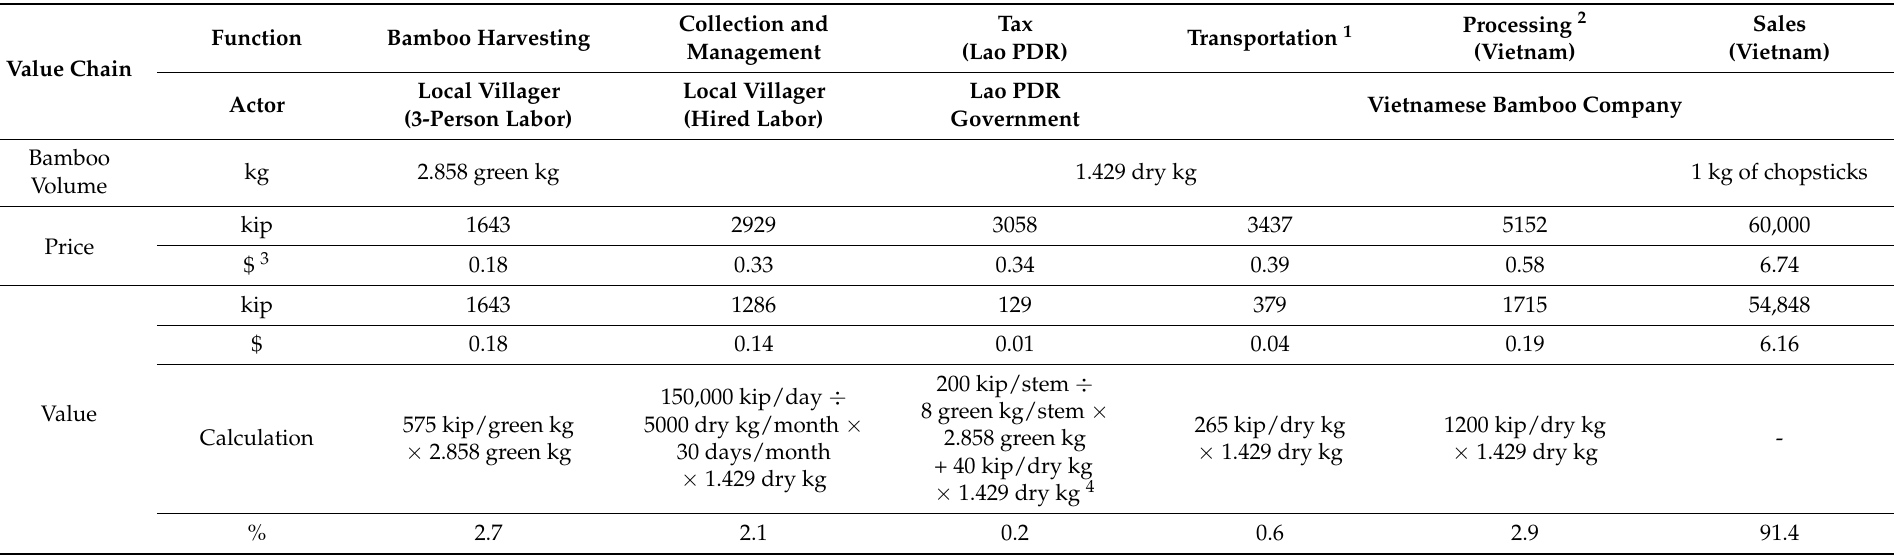
Table 4. Bamboo chopsticks value chain in Nongboua village, Sangthong district, in